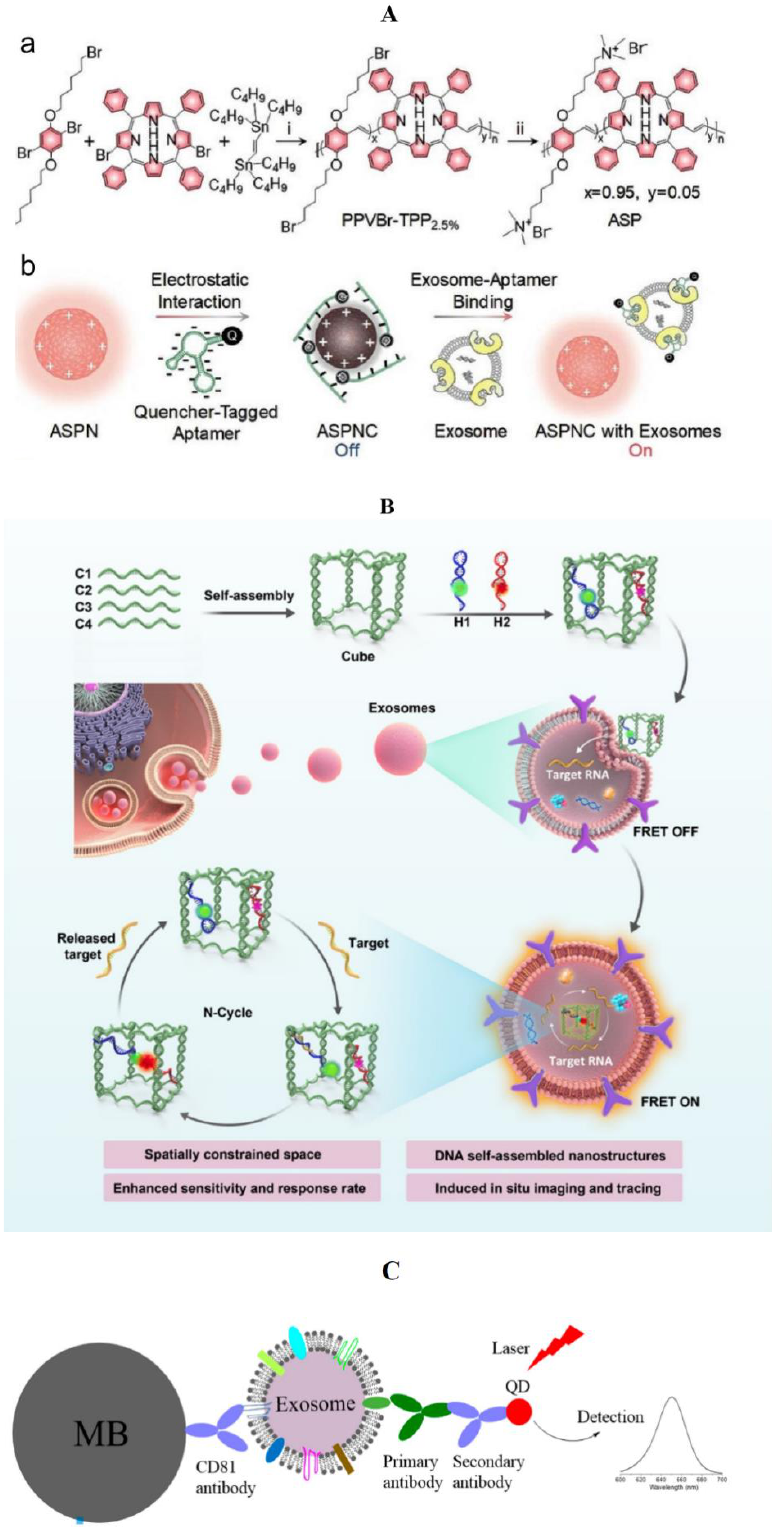
Figure 5. Detection of exosomes in breast cancer by the fluorescence method (nanometer materials). ( A ) Design and sensing mechanism of ASPNC [103]: (a) synthetic route of ASP. (b) Illustration of the formation of ASPNC and the afterglow detection of exosomes; ( B ) schematic Illustration of the assembly process and operational mechanism of DDCA [104]; ( C ) schematic of the QD-based EXO assay [108].